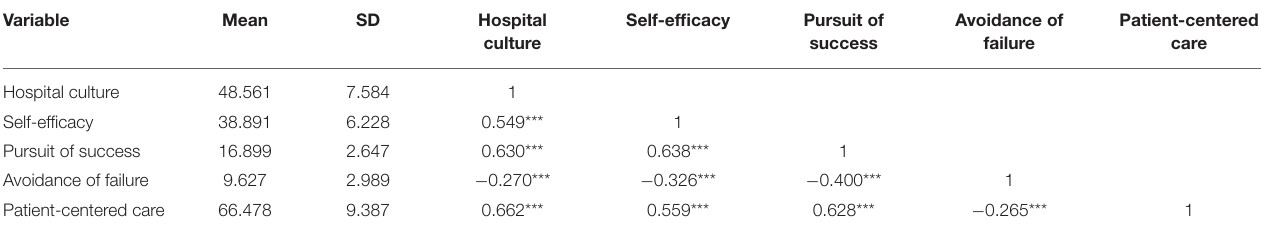
TABLE 3 | Means, standard deviations, and correlation coefficients of the variables. Variable